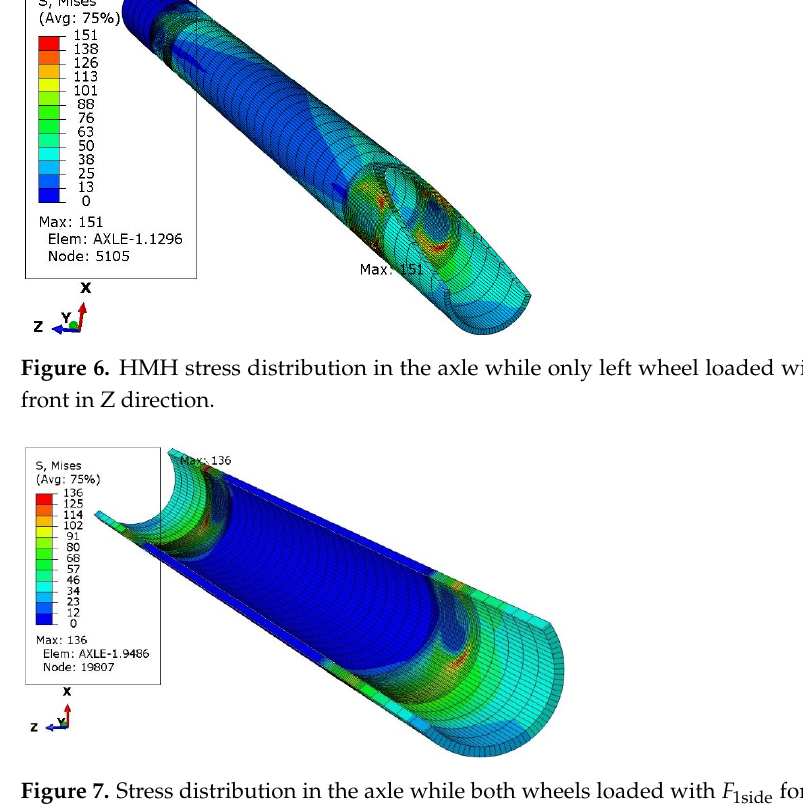
Figure 7. Stress distribution in the axle while both wheels loaded with F 1side